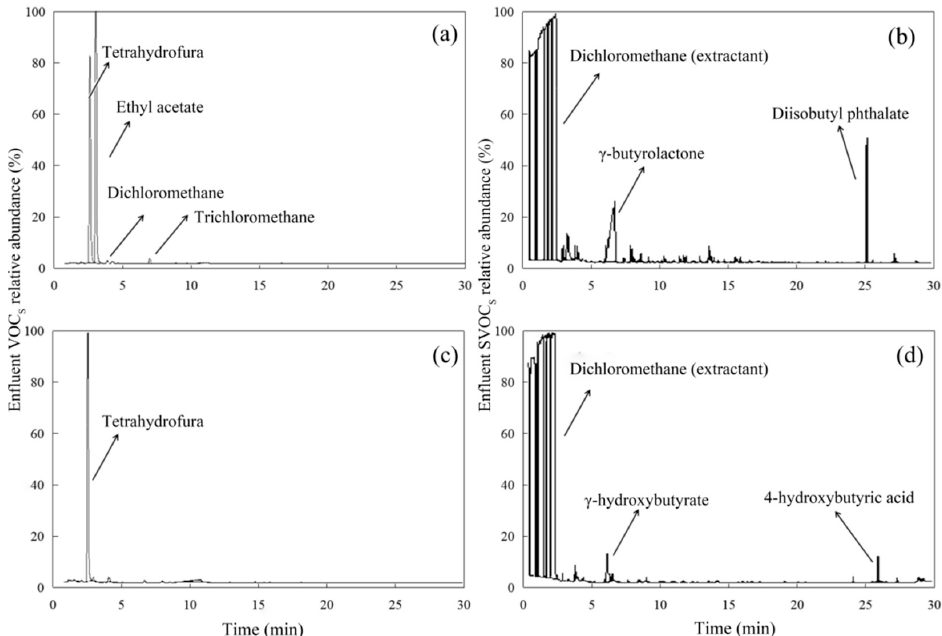
Figure 3. GC-MS spectra of pharmaceutical wastewater degradation process. ( a ) Electro-Fenton effluent of VOCs; and ( b ) SVOCs; ( c ) 3D-BERs effluent of VOCs; and ( d ) SVOCs.